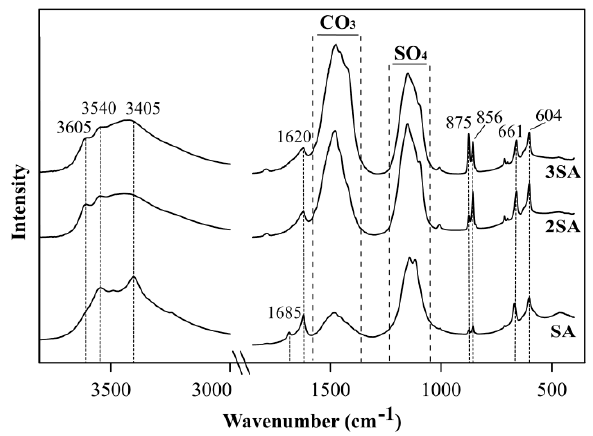
Figure 7. The FTIR spectra of solid phases precipitated as a result of AMD treatment by SA, 2SA, and 3SA.